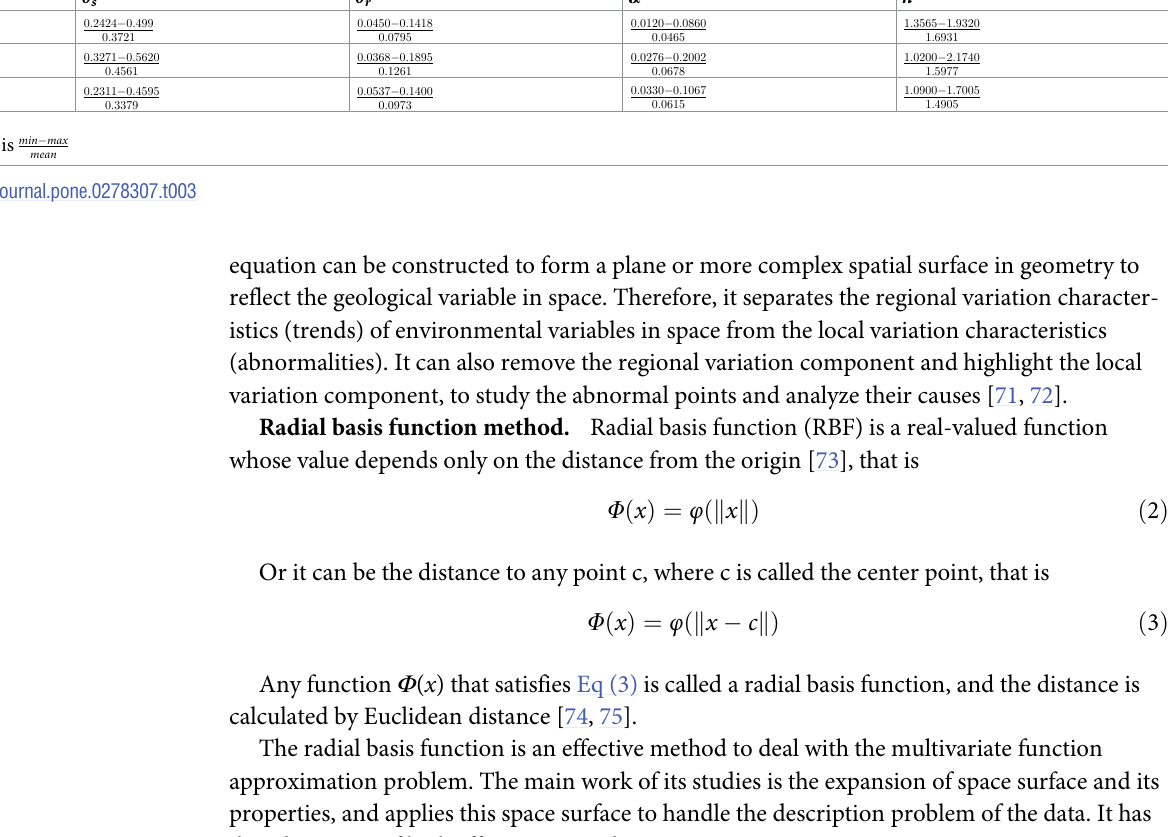
Table 3. VG model parameters table for each